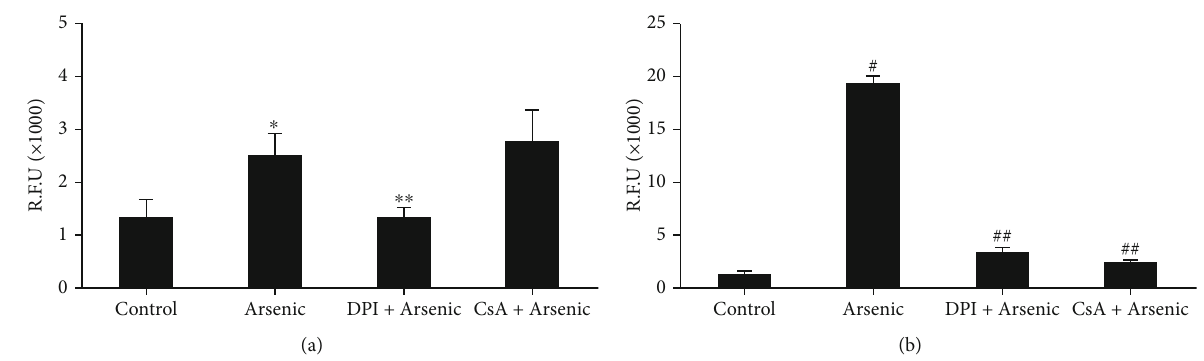
Figure 2: E ff ect of DPI, a NOX inhibitor, and cyclosporin, an inhibitor of mitochondrial permeability transition (MPT), on arsenic-induced ROS generation in primary cultured mouse hepatocytes. Cells were pretreated with either DPI or cyclosporin (10 μ M) at least 30min before the treatment of 10 μ M arsenic. (a) After 1 h of arsenic treatment, quantitative assessment of ROS production was measured by multimode plate reader. ∗ p < 0 : 01 vs. control; ∗∗ p < 0 : 004 vs. arsenic; (b) after 3 h of arsenic treatment, quantitative assessment of ROS production was measured by multimode plate reader. # p < 0 : 001 vs. control; ## p < 0 : 001 vs.